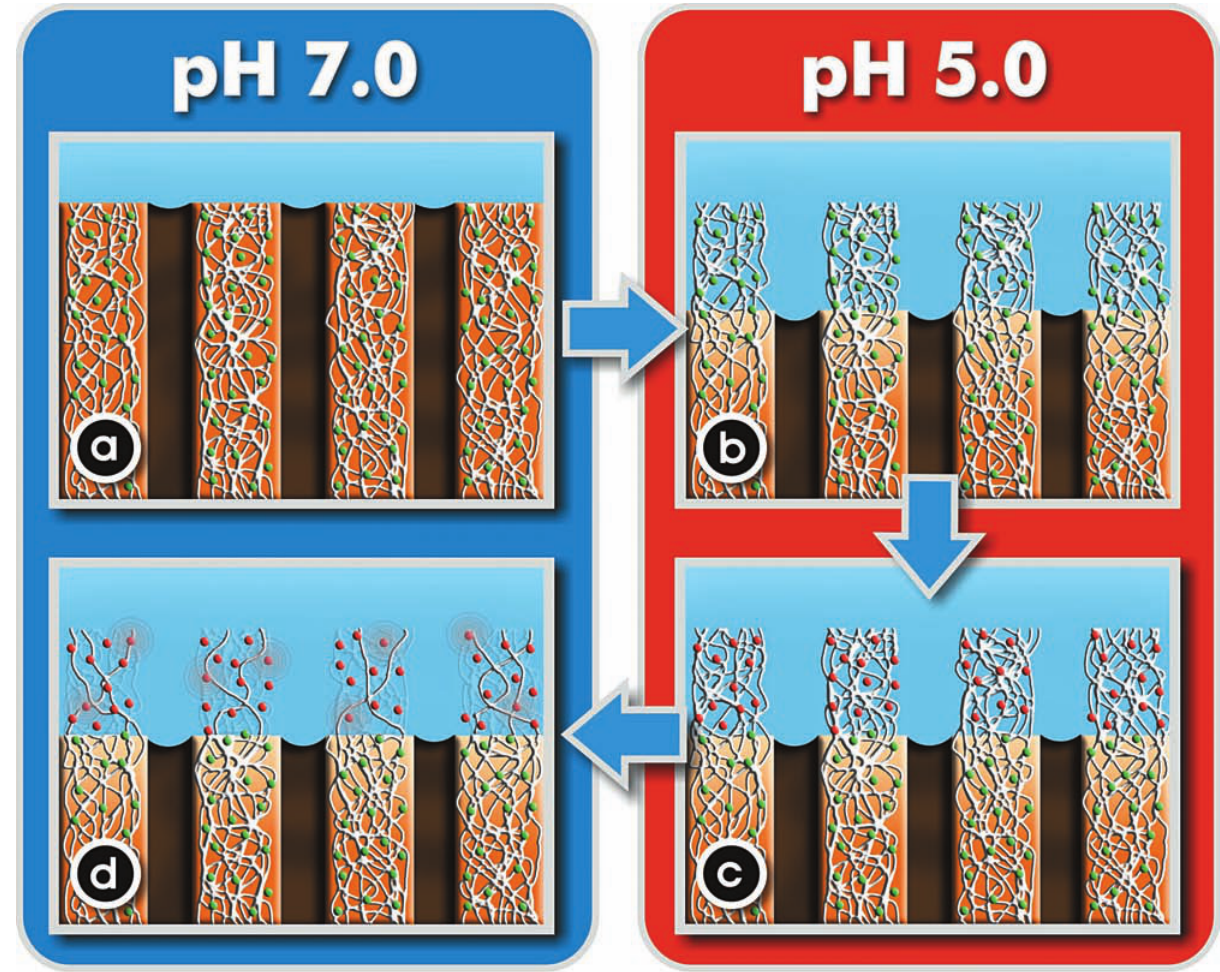
Figure 2- Schematic illustration of the process of dentin dissolution by bacterial acids. Under resting conditions (pH 7.0) both the mineral and organic matrix (containing inactive MMPs, green dots) are intact (a). Upon a cariogenic challenge (pH 5.0), the apatite is dissolved thus exposing the organic matrix to degradation by salivary and dentin MMPs (green dots represent MMPs) (b). The low pH also activates MMPs, which are represented as red dots (c). The subsequent neutralization by salivary buffer systems enhances the degrading activity of the organic matrix by MMPs (d)